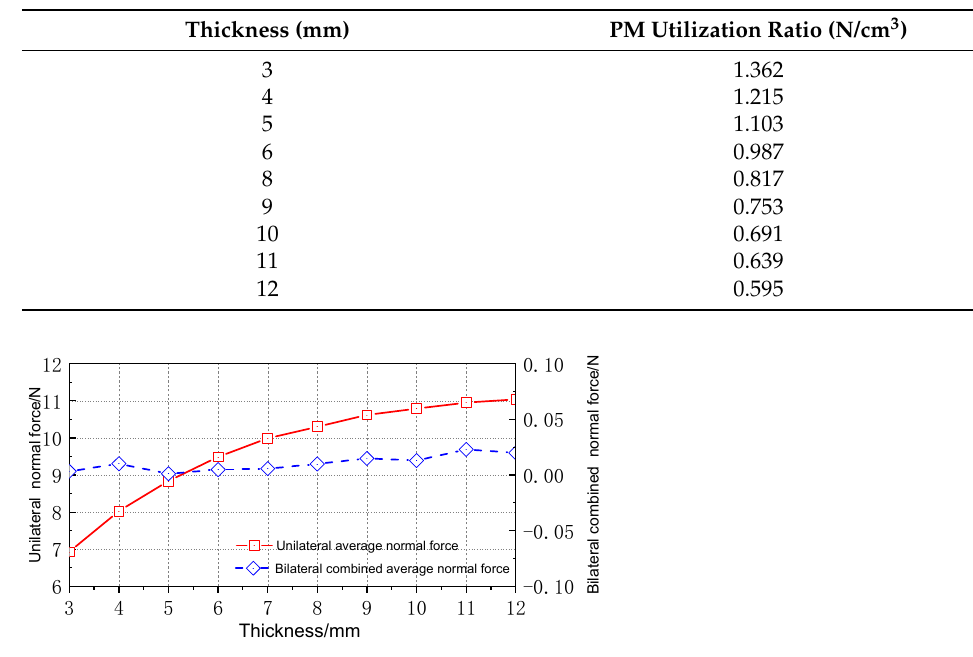
Figure 13. The curve of normal force variation with ℎ .